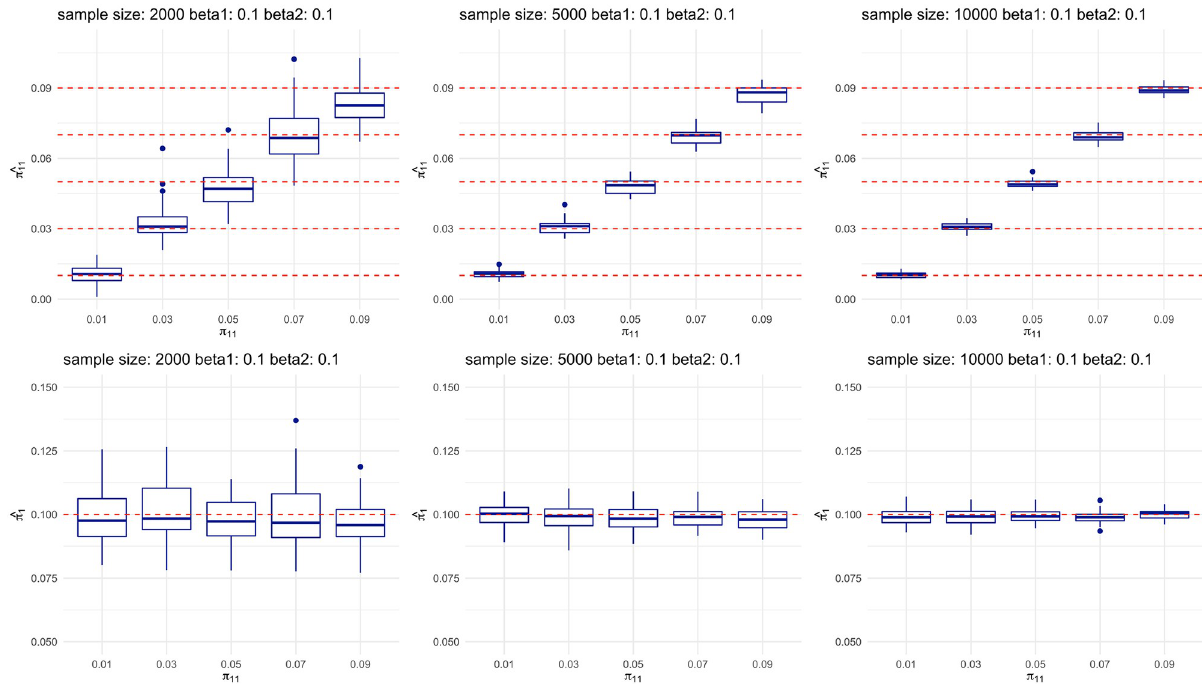
Fig 1. Multi-trait analysis can accurately estimate the proportion of shared risk genes and single-trait risk genes. Top panels show the estimation of shared risk proportion, and bottom panels show the estimation of a single trait. For each panel, each plot from left to right represents study sample size of 2000, 5000, and 10000, respectively. Within each plot, boxes from left to right represent the proportion of shared risk genes being 0.01, 0.03, 0.05, 0.07 and 0.09, respectively. Each scenario is replicated for 50 times in our simulations. True values are shown in red dashed lines.